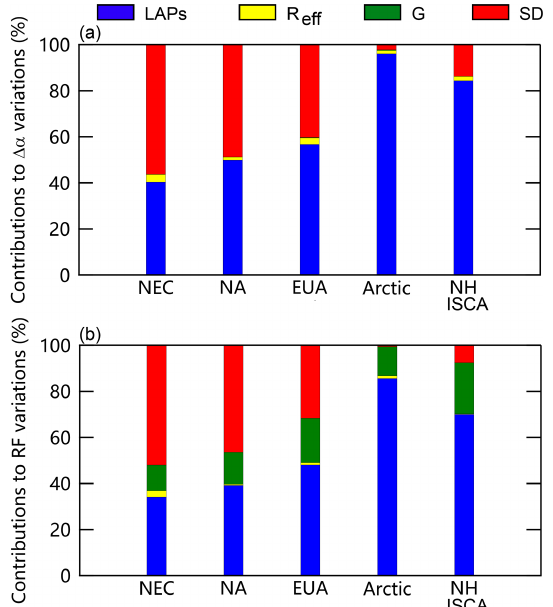
Figure 9. Fractional contributions of LAPs, snow grain size ( R eff ), geographic factor ( G ), and snow depth (SD) to the spatial variations in (a) snow albedo reduction and (b) daily radiative forcing.